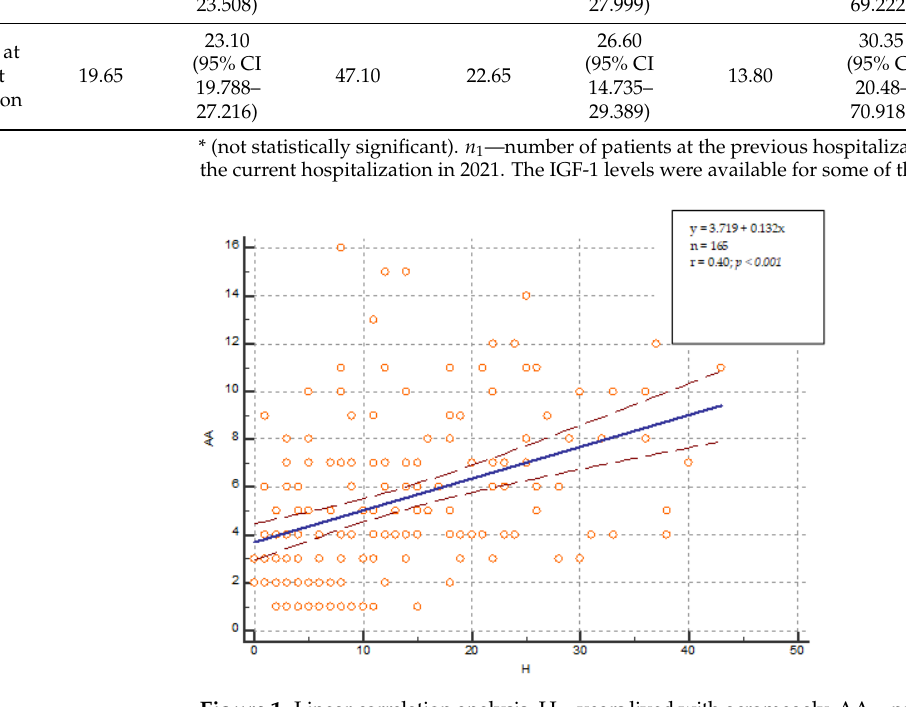
Figure 1. Linear correlation analysis. H—years lived with acromegaly. AA—number of